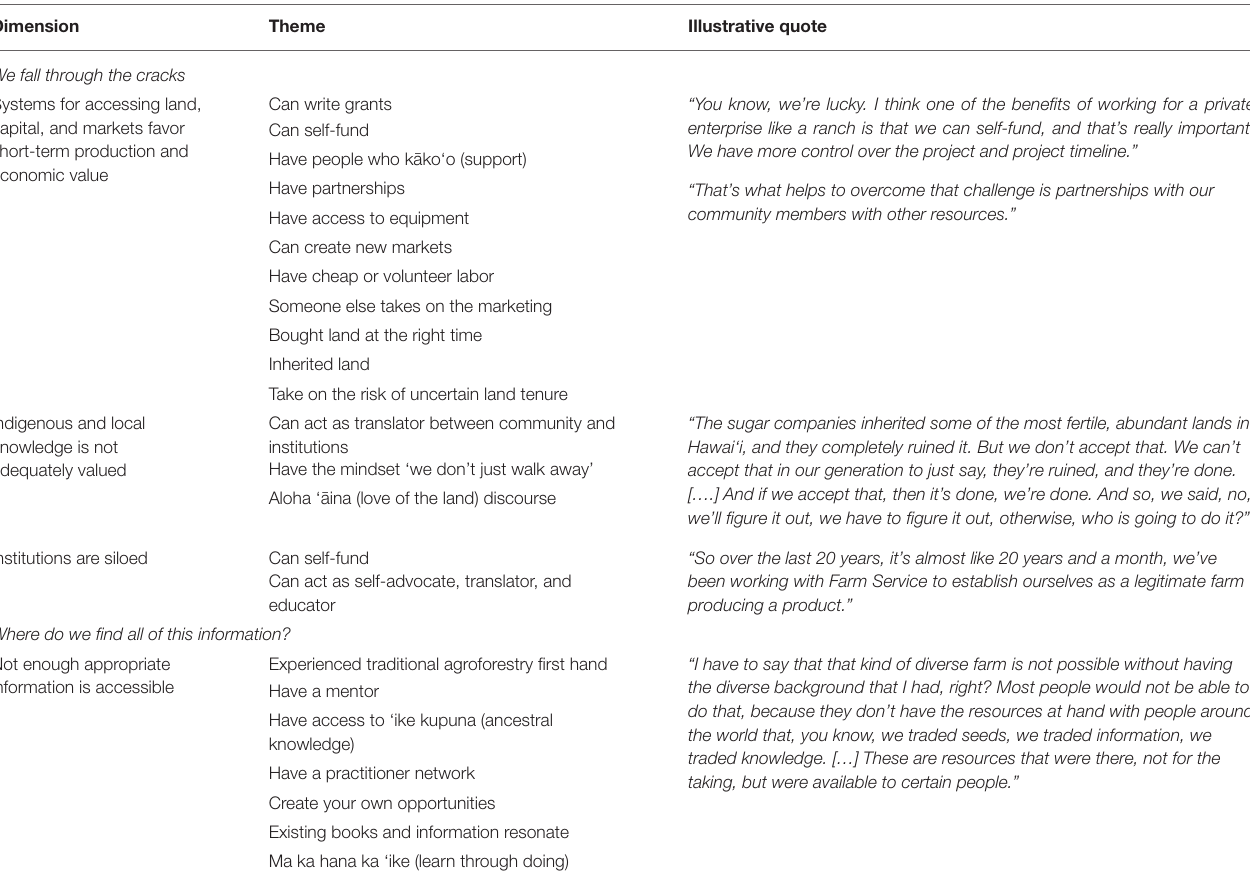
TABLE 3 | Factors influencing practitioners ablity to participate in transitions to agroforestry in Hawai‘i related to each dimension of agroforestry-specific obstacles.